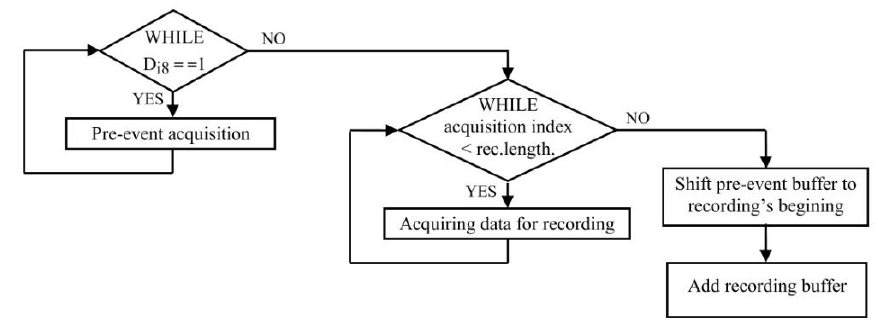
Figure 5. Recording with pre-event sequence flowchart.